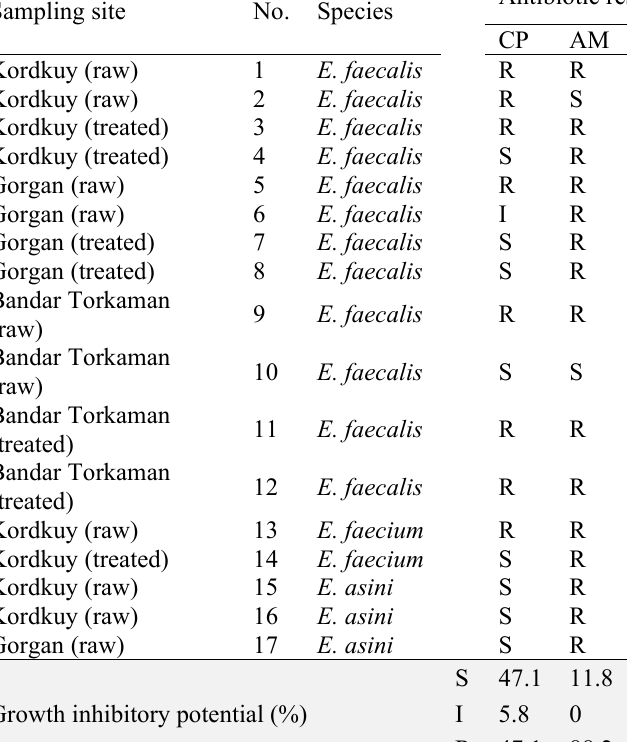
Antibiotic resistance pattern